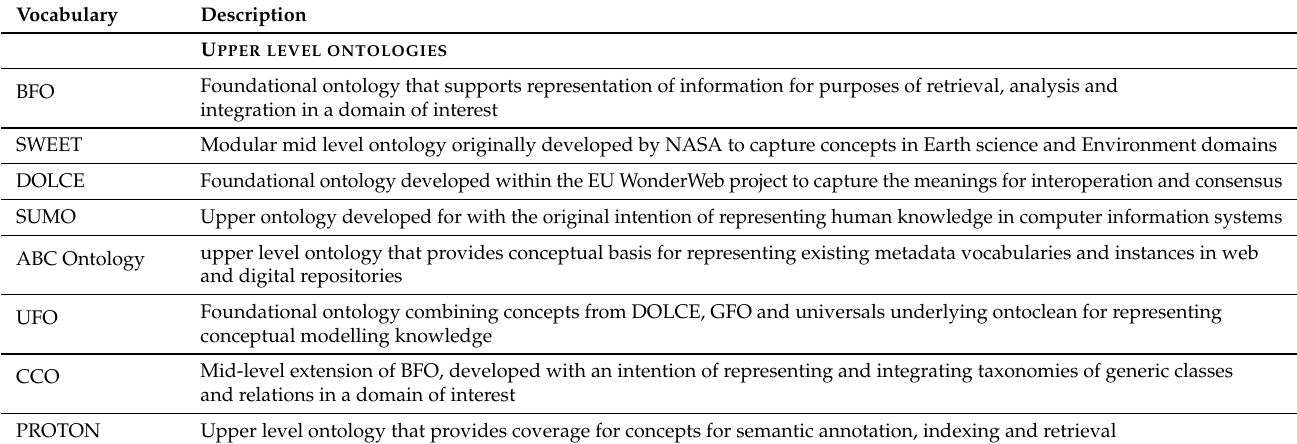
Table A1. Reused Ontologies in the Disaster Management